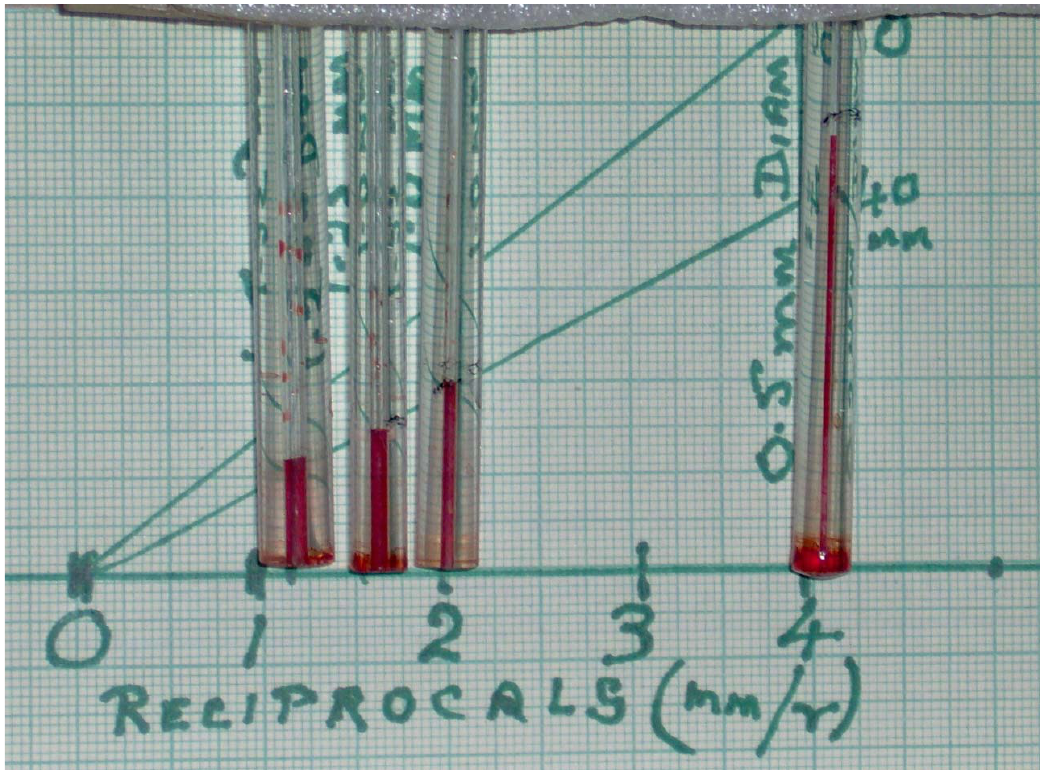
Figure 1. A group of narrow glass capillary tubes with columns of water drawn up to